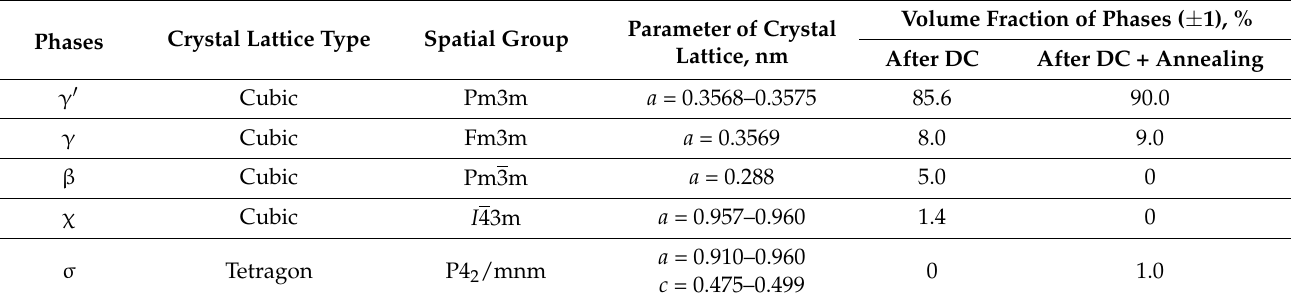
Table 1. Phase composition and quantitative properties of